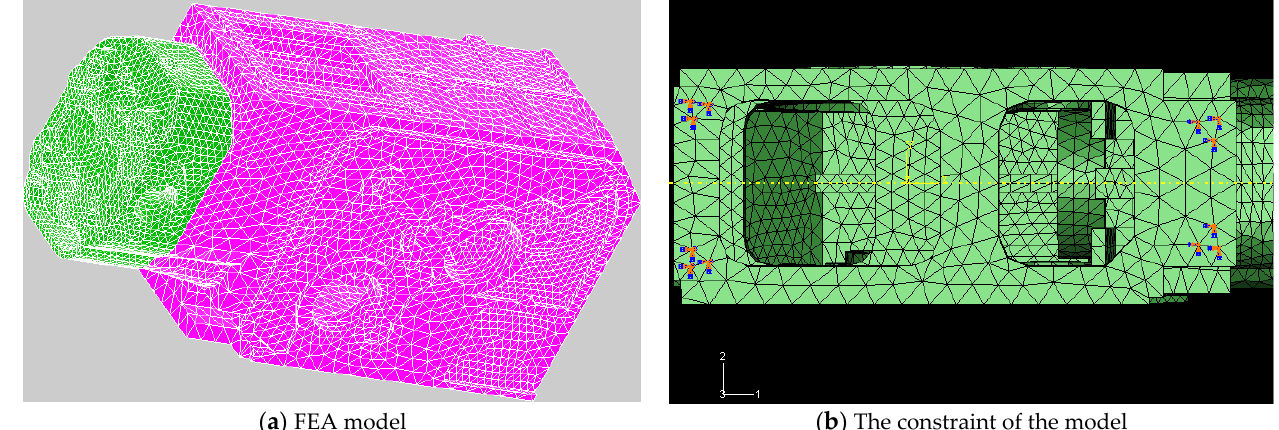
Figure 3. The model and constraint of the one-cylinder engine.